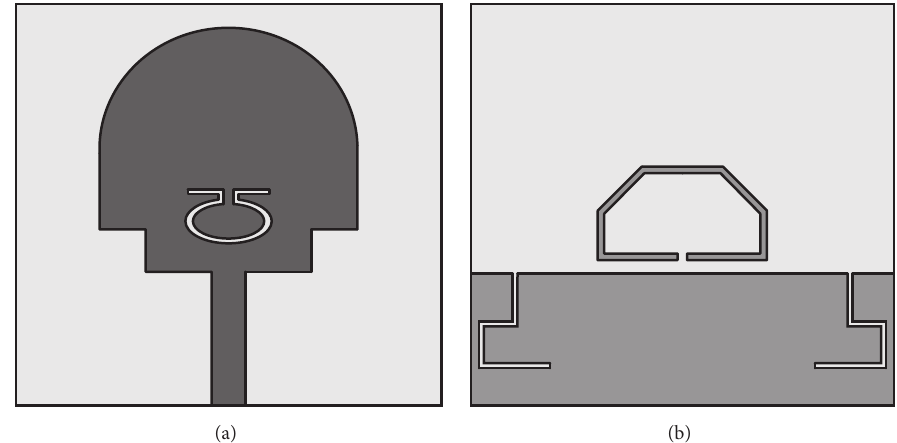
Figure 53: Geometry of a planar UWB monopole antenna with triple band-notched characteristics [62]. Top view (a) and bottom view (b). The resonant filters are shown in the figure. Dark gray upper metal face, medium gray bottom metal face, and light gray dielectric substrate.